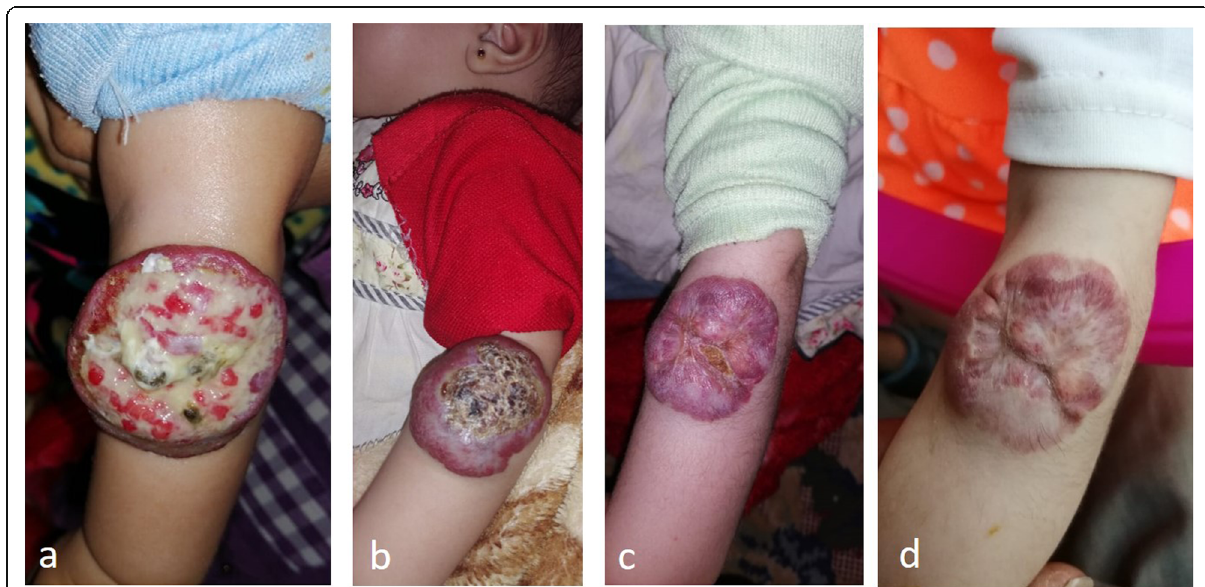
Fig. 2 Infantile haemangioma of the upper limb in the same patient at different stages. a The lesion at the age of 3 months showing marked overlying skin ulcerations during rapid proliferative phase. b , c Progress showing gradual healing by daily dressing and oral propranolol therapy. d Regression of the haemangioma at the age of 18 months